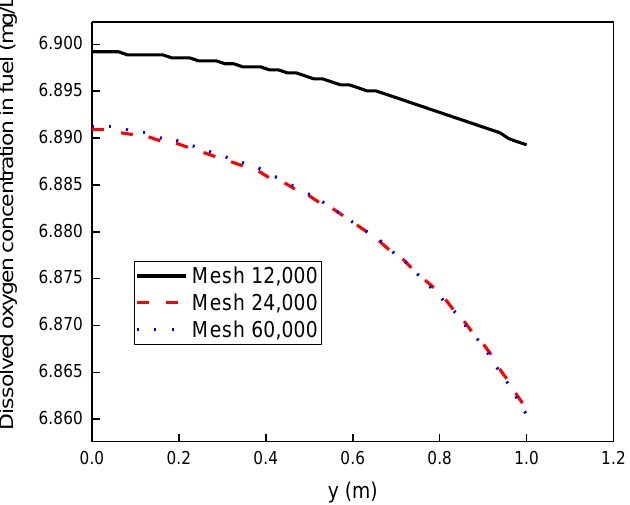
Figure 3. Distribution of dissolved oxygen concentration in fuel under different grid quantities.